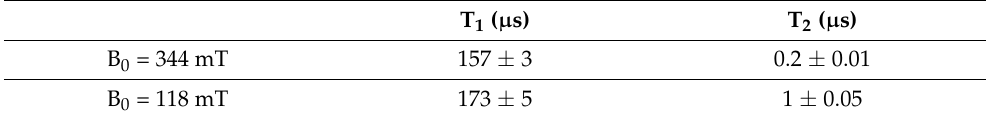
Table 2. Relaxation times obtained at T = 12